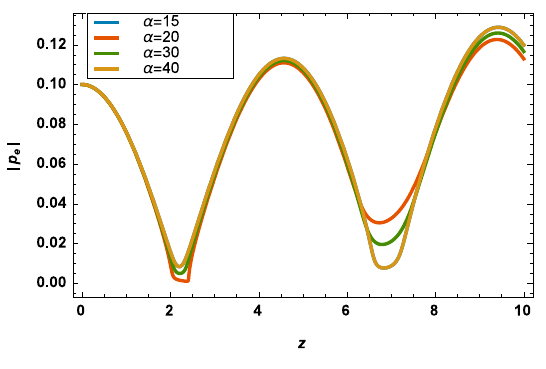
Fig. 9 Pressure along Tapered Tube for Various Values of α with λ a = 0 . 5 , β = 0 . 5